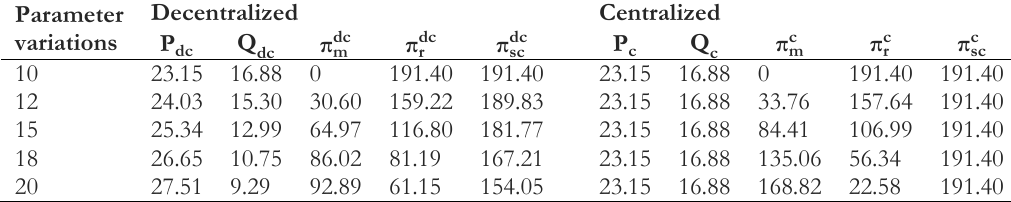
Table 5. Sensitivity analysis of the objective functions ’ values for the wholesale price parameter.